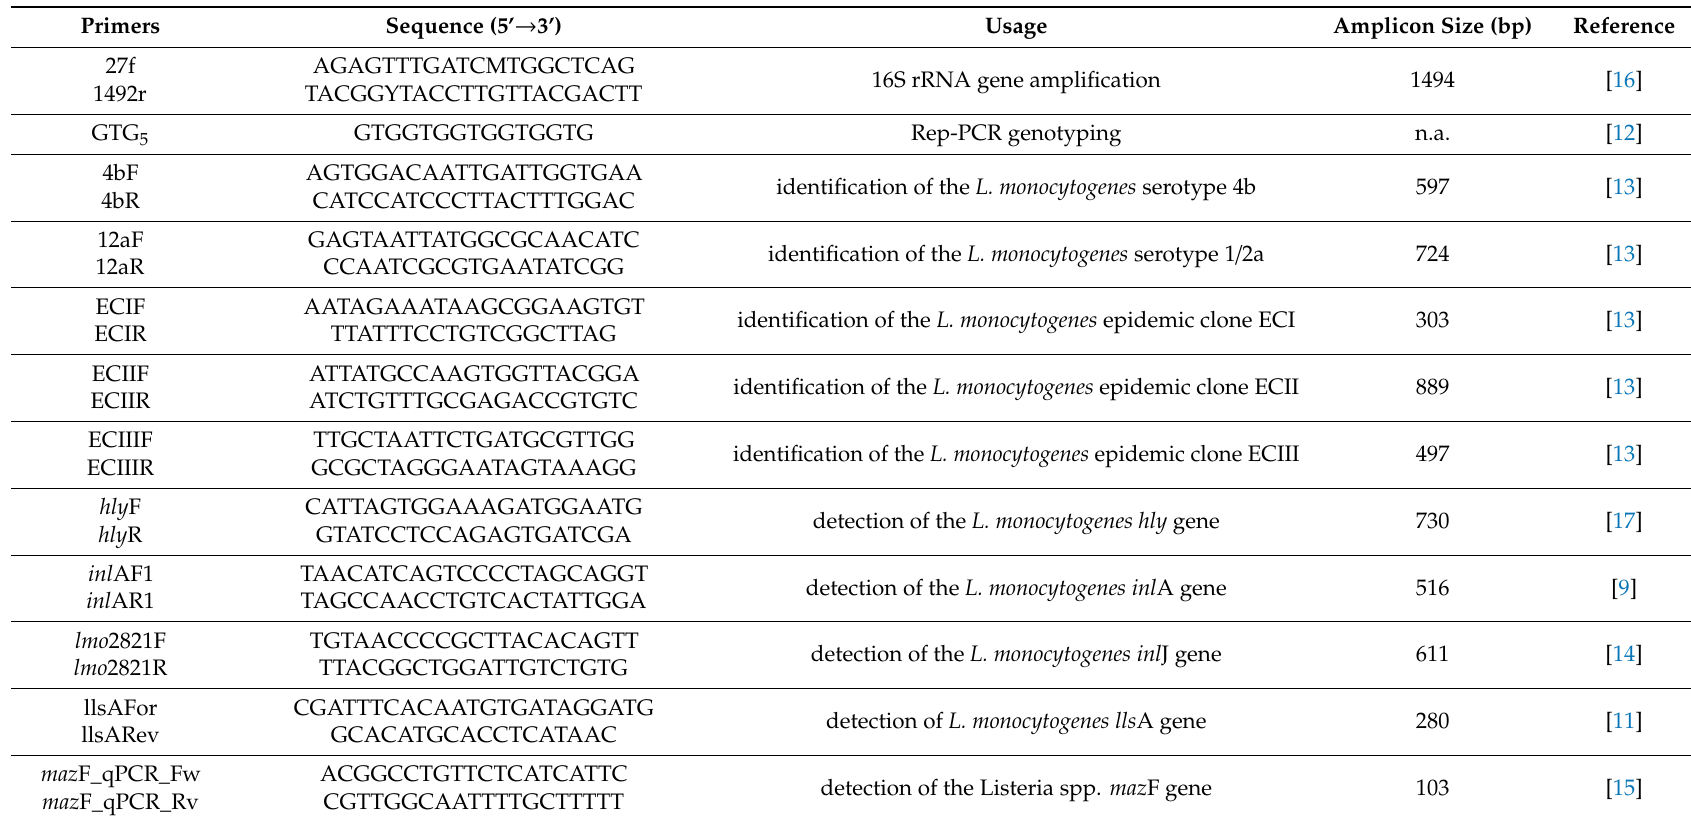
Table 2. PCR primers used in this study, respective targets, amplicon size and